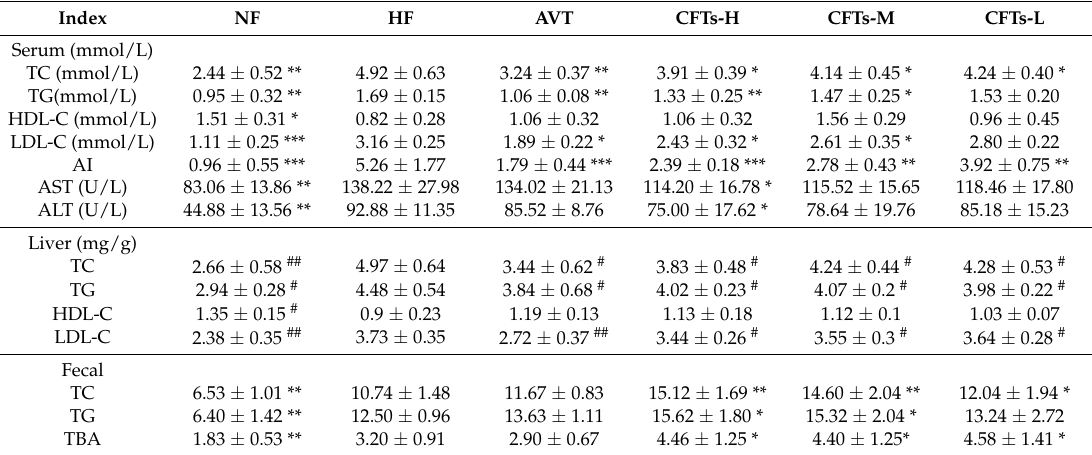
Molecules 2019 , 24 , x FOR PEER REVIEW